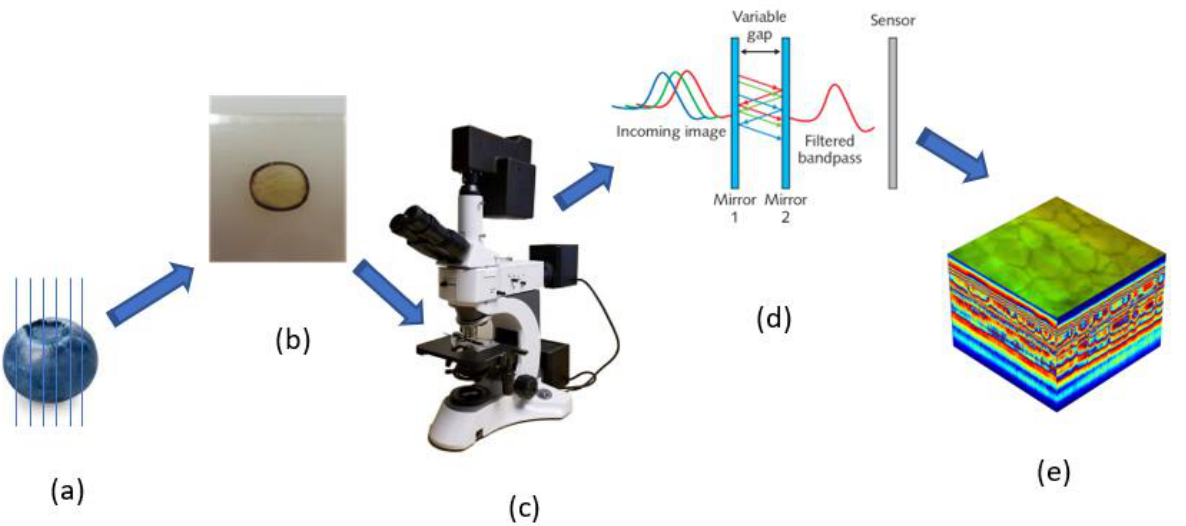
ple preparation and hyperspectral microscopic image measurement.